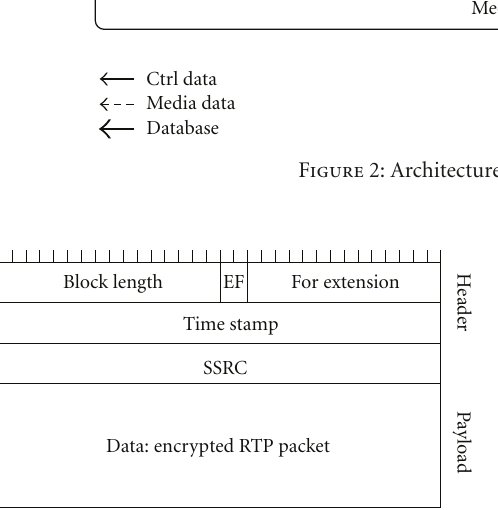
Figure 3: Block structure of encrypted RTP packet in RPS media file.